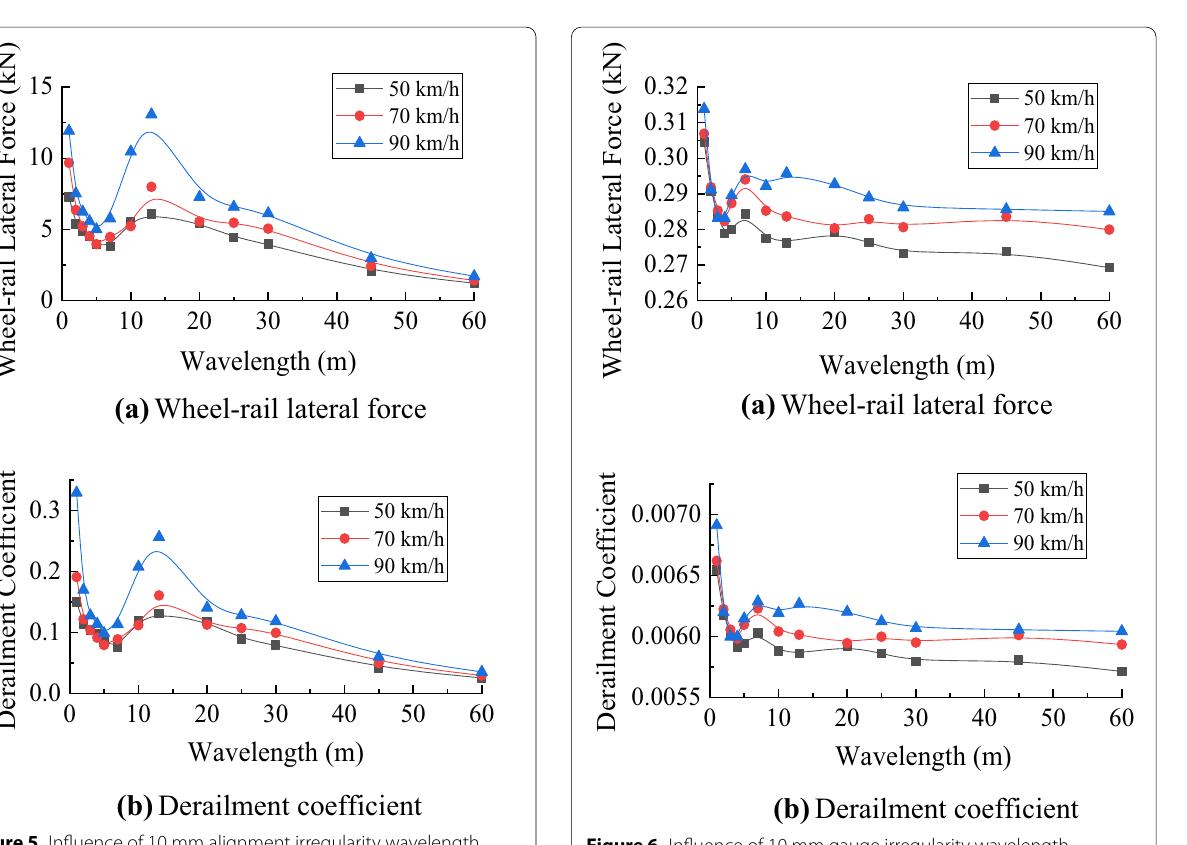
Figure 5 Influence of 10 mm alignment irregularity wavelength amplitude on derailment coefficient and wheel-rail lateral force